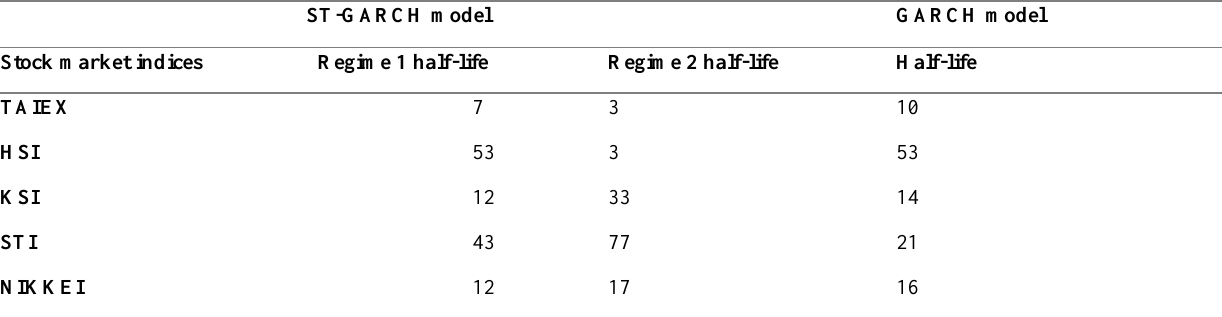
Table 6: The estimation of volatility half-life for different regimes of ST-GARCH